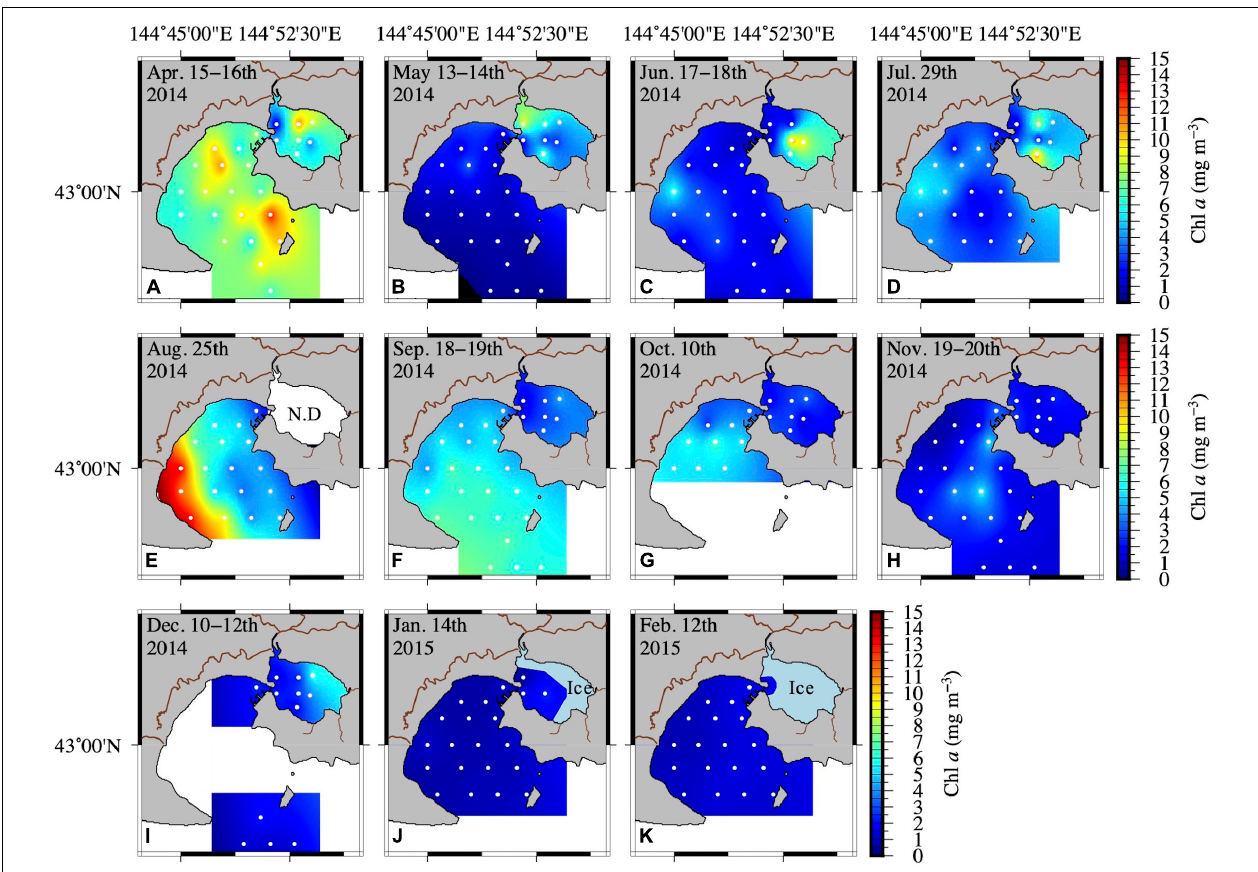
FIGURE 4 | Spatial distribution of Chl a concentration at the surface (A–K) from April 2014 to February 2015. Inter- and extrapolation of the data were implemented by the General Mapping Tools. White symbols in each figure represent the sampling sites.